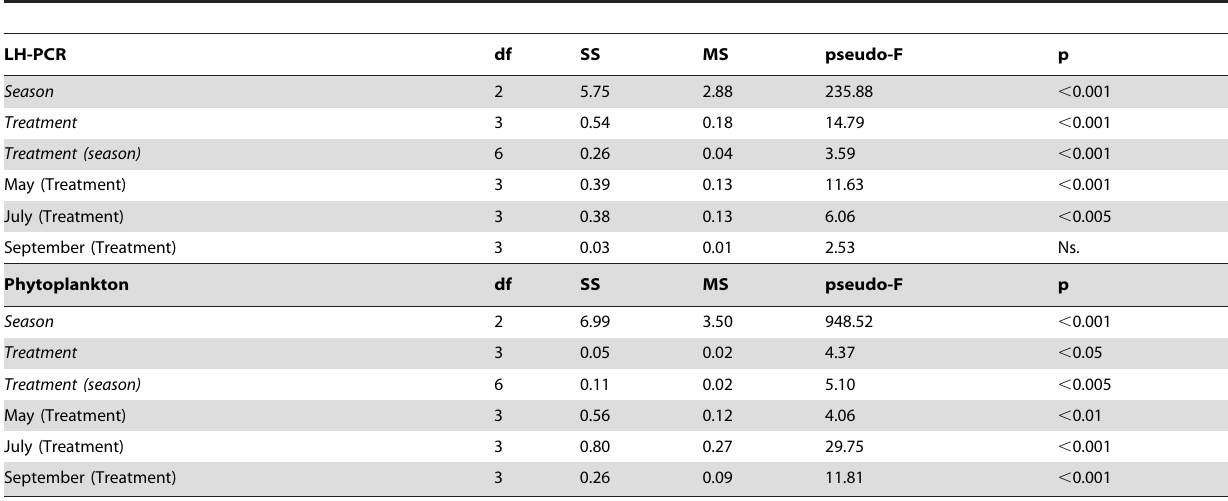
Table 3. Results from a permutational multivariate analysis of variance comparing the bacterial (LH-PCR) and phytoplankton communities among seasons (experiments) and after nutrient additions (treatments).